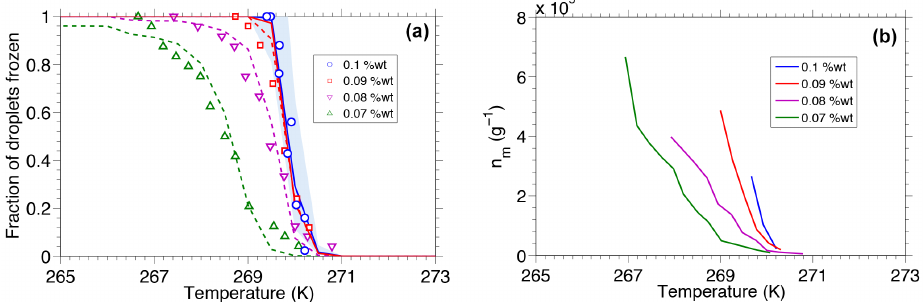
Figure 6. (a) Experimental freezing curves for different mass concentrations of commercial Snomax powder immersed in 500–700µm diameter water droplets obtained using the CMU cold plate (circles). Solid lines are fits produced from randomly sampling from the g distribution retrieved from the highest concentration freezing curve (0.1%wt). Dashed lines are fits produced from randomly sampling from the g distribution and a surface area correction. The second highest concentration freezing curve (0.09%wt) is used to confirm the critical area threshold had been exceeded. The shaded region represents the effect of variability in surface area as in Fig. 5 but for a droplet diameter range of 500–700µm for the highest particle concentration. (b) Ice active site density ( n m ) retrieved from the frozen fraction data on the left. A trend of decreasing n m with decreasing concentration is observed for the droplets containing